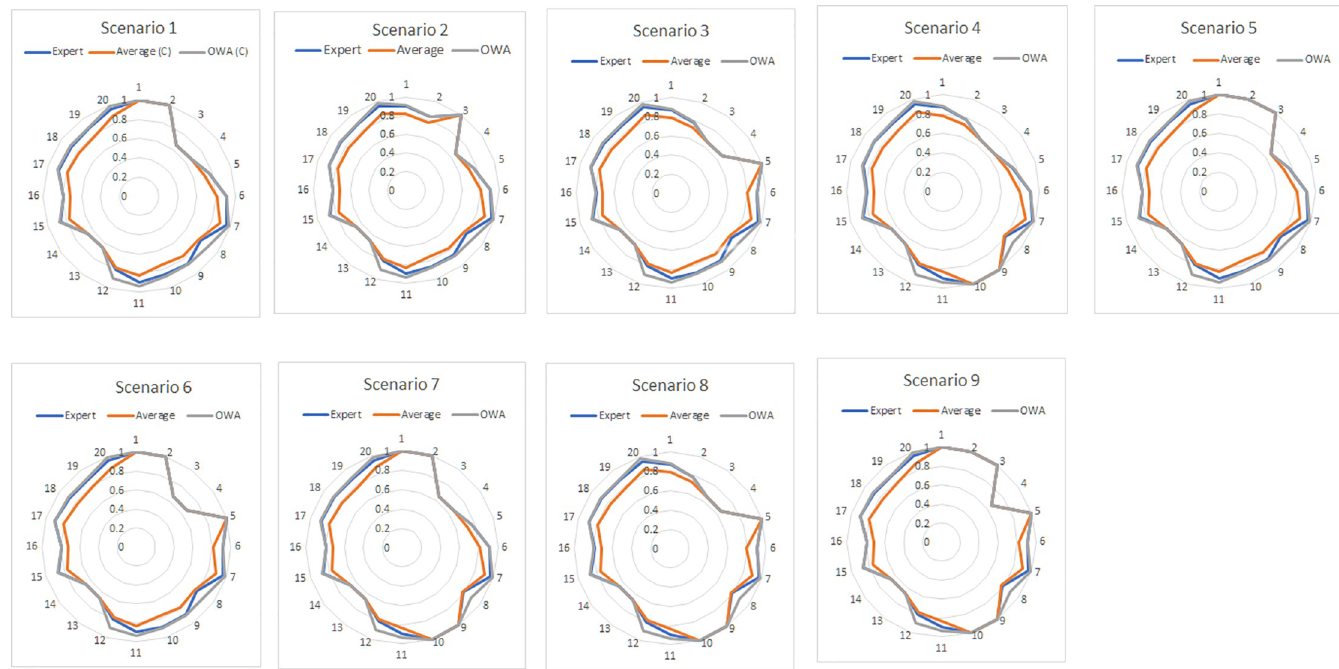
Fig 7. Spider graphs for the Expert-based, Average, and OWA-FCMs (C).